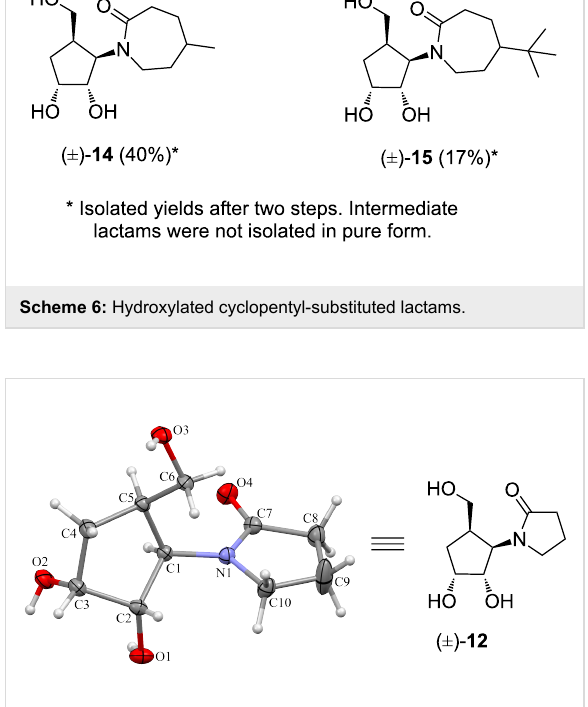
Figure 2: ORTEP plot of triol (±)- 12